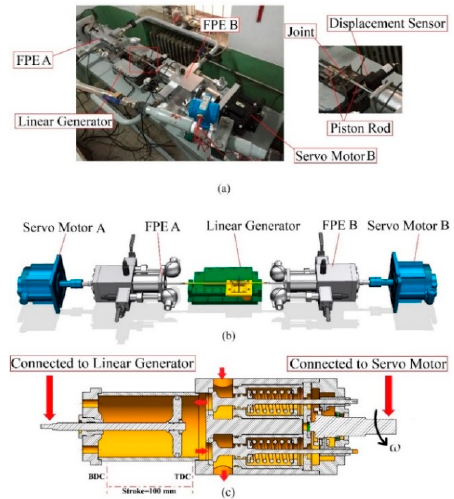
Figure 1. Prototype and 3D model of the free piston expander ‐ linear generator (FPE ‐ LG): ( a ) FPE ‐ LG prototype; ( b ) 3D model of the FPE ‐ LG; ( c ) Cross ‐ sectional view of the free piston expander (FPE).